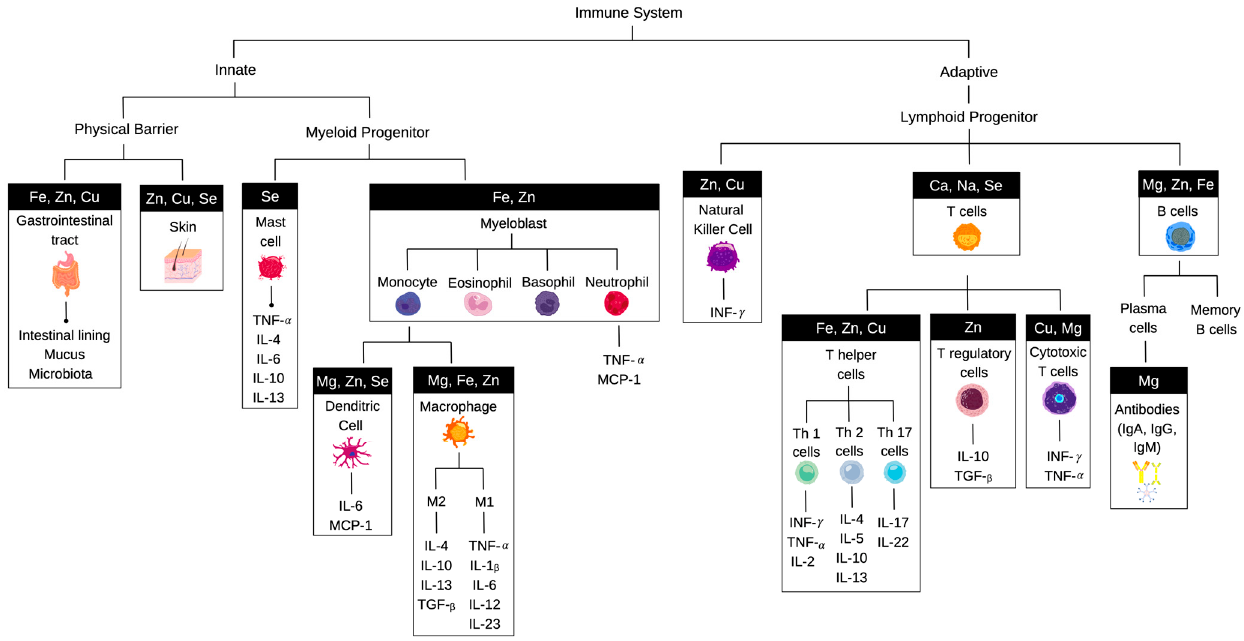
Figure 1. Schematic representation of the immune cell lineages of lymphoid and myeloid origin. Essential minerals that play important roles in maturation and activation of the immune cell sub- groups are shown at the top. The major effector molecules produced by each subgroup include cy- tokines, interleukins, and chemokines as listed below the individual clades.